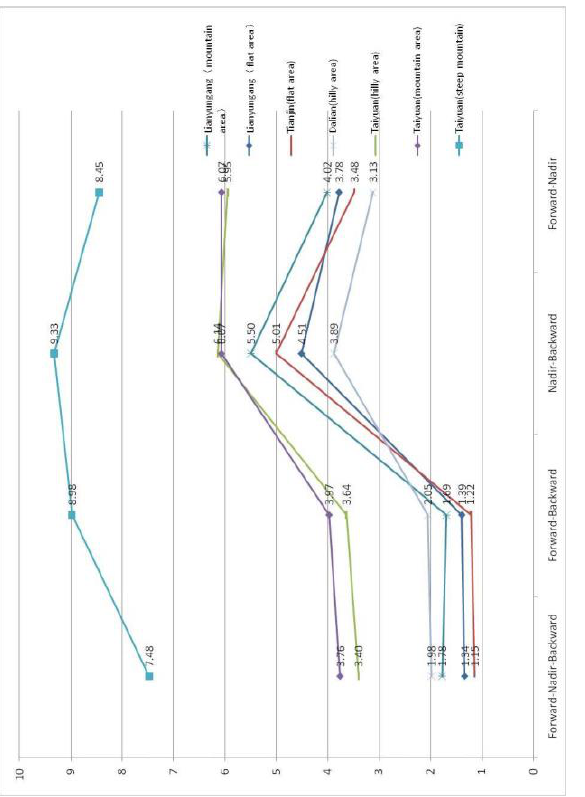
Figure 1. The comparison of DSM accuracy with different stereo view methods and test morphology. Figure 2. The comparison of DSM accuracy between 25m grid and 10m grid with different stereo view